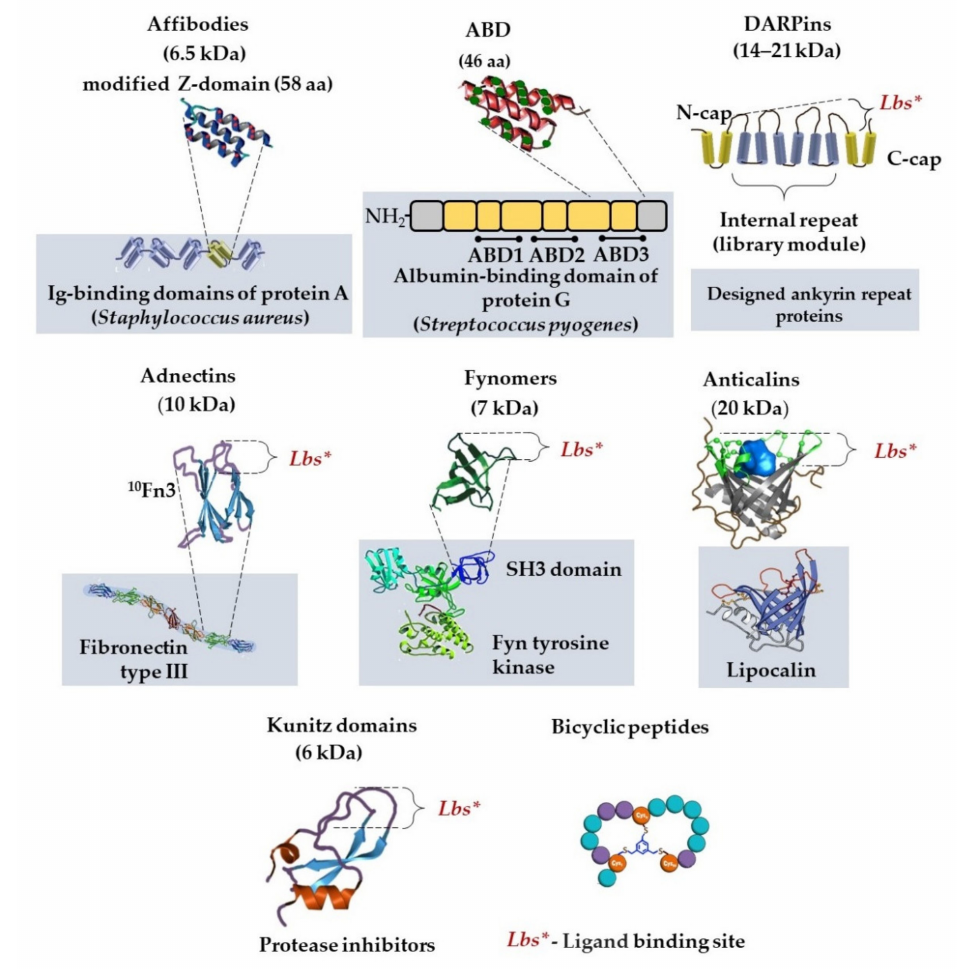
Figure 3. Non-immunoglobulin alternative protein